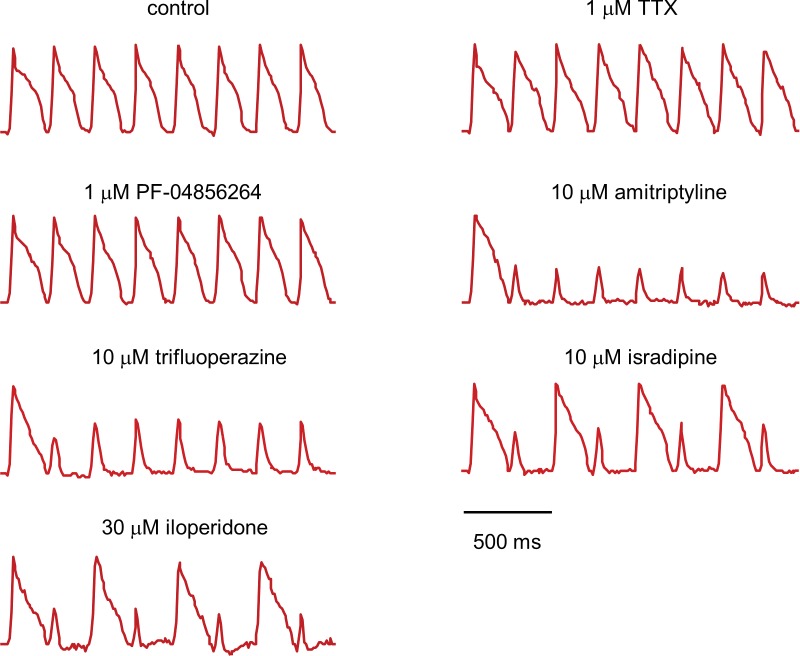
Fluorescence traces from NaV1.5-OS HEK cells with different drugs.NaV1.5-OS HEK cells were stimulated with eight pulses of blue light (20 ms, 50 mW/cm2) at 4 Hz, and QuasAr2 fluorescence was monitored with 635 nm excitation, 400 W/cm2. TTX and PF-04856264 had little effect on channel function. Amitriptyline and trifluoperazine showed strong use-dependent block. Isradipine and iloperidone showed use-dependent block with fast recovery, leading to alternating response amplitudes.